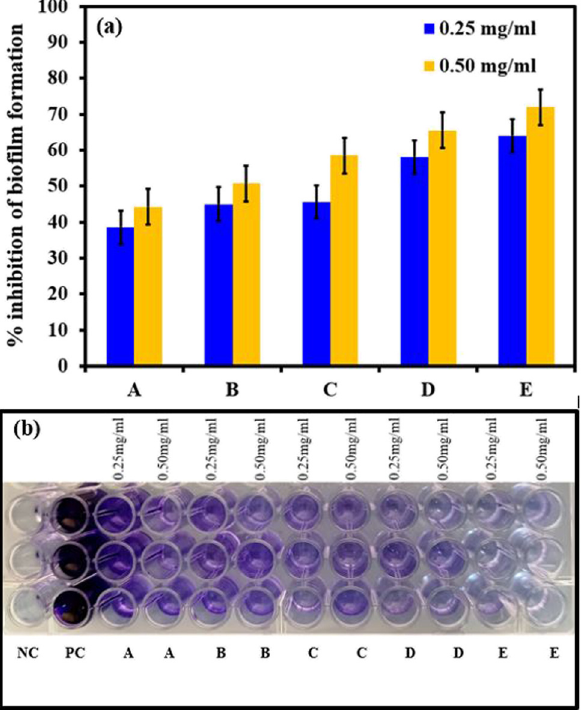
Figure 8: ( a ) E ff ects of nanocomposites on bio fi lm formation abil - ities of P. aeruginosa ; ( b ) 96 - well microtiter plate showing bio fi lm inhibition of gram - negative P. aeruginosa in the presence of nano - composites. NC: culture media only, without bacteria and nano - composites; PC: culture media inoculated with P. aeruginosa , but without nanocomposites: bio fi lm inhibition in the presence of 0.25 and 0.5 mg/mL of nanocomposites ( A = g - C 3 N 4 , B = 2.5% - n - NiO@g - C 3 N 4 , C = 5% - n - NiO@g - C 3 N 4 , D = 10% - n - NiO@g - C 3 N 4 , and E = 20% - n - NiO@g - C 3 N 4 )